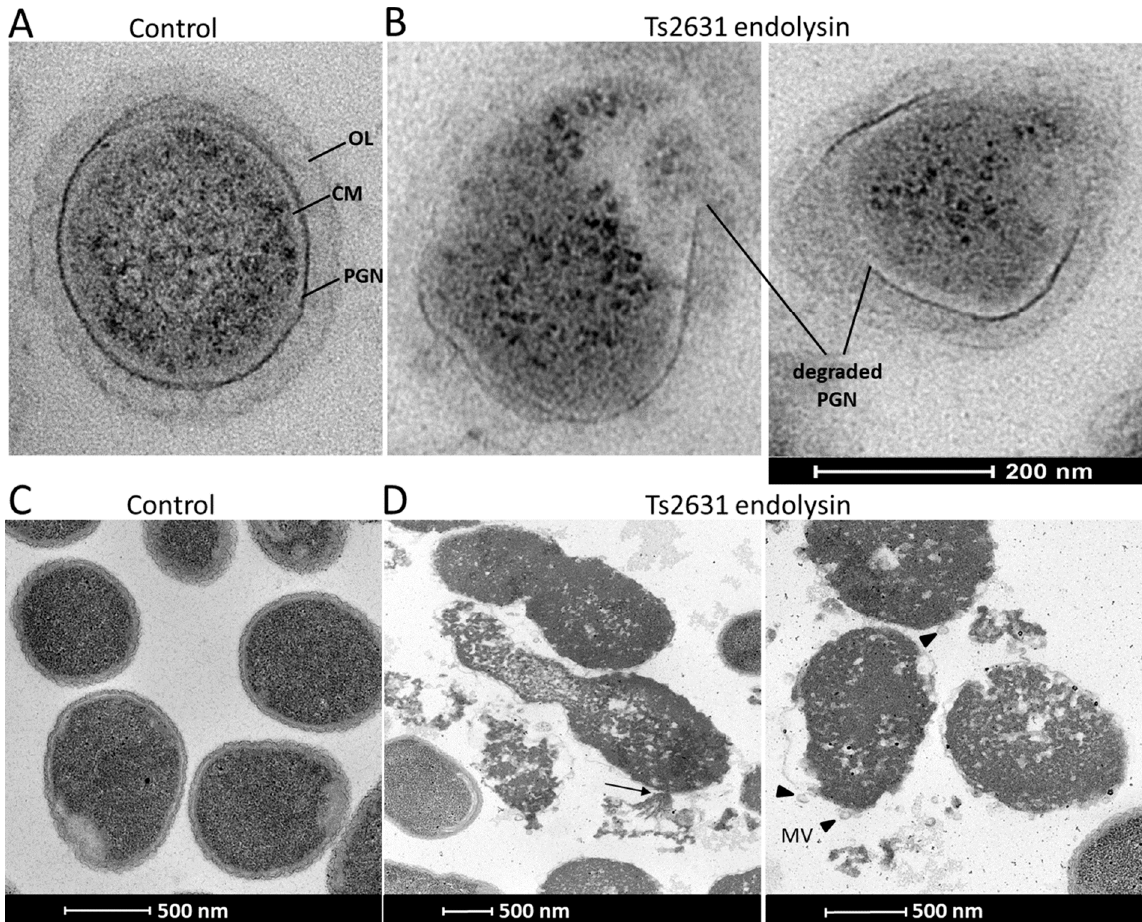
Figure 2. Transmission electron microscopy of T. thermophilus HB8 and A. baumannii KPD 205 cells treated with Ts2631 endolysin. ( A ) A cross-section of untreated T. thermophilus HB8 cells at a scale of